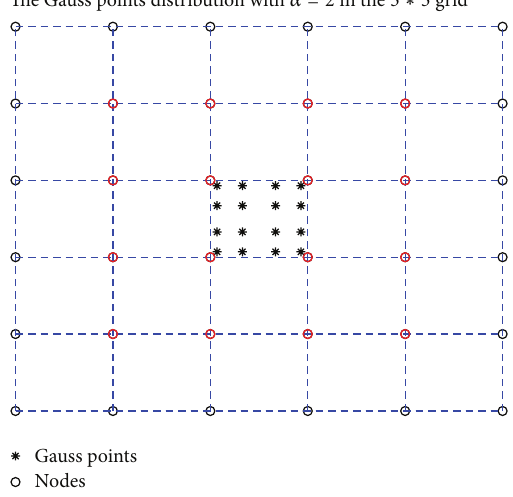
Figure 10: The diagram of 5 ∗ 5 domains for the special